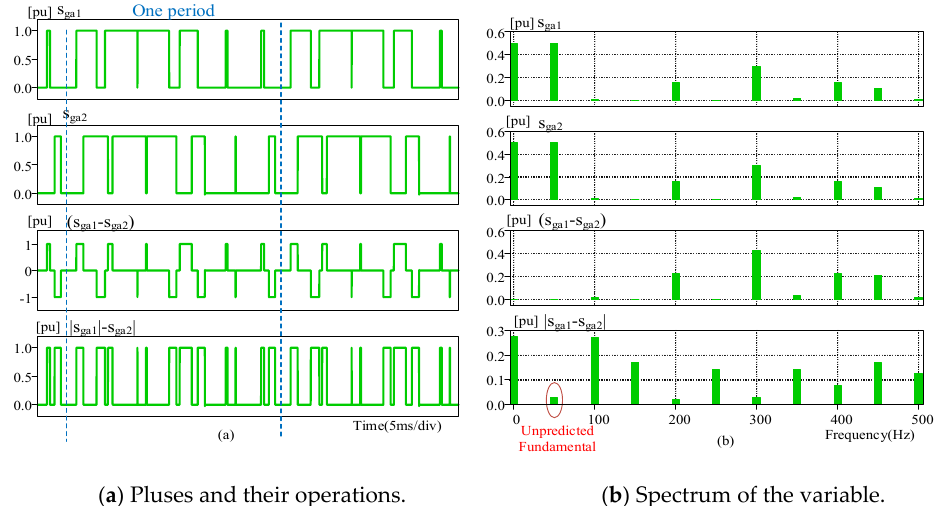
Figure 7. Pluses and their spectrum when C r = 6.